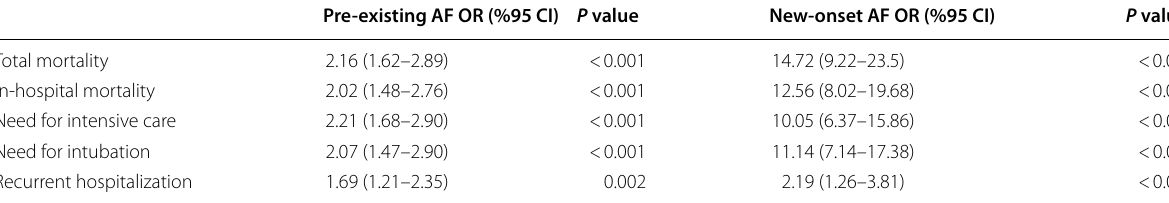
Table 2 Effects of AF types on the course of the disease